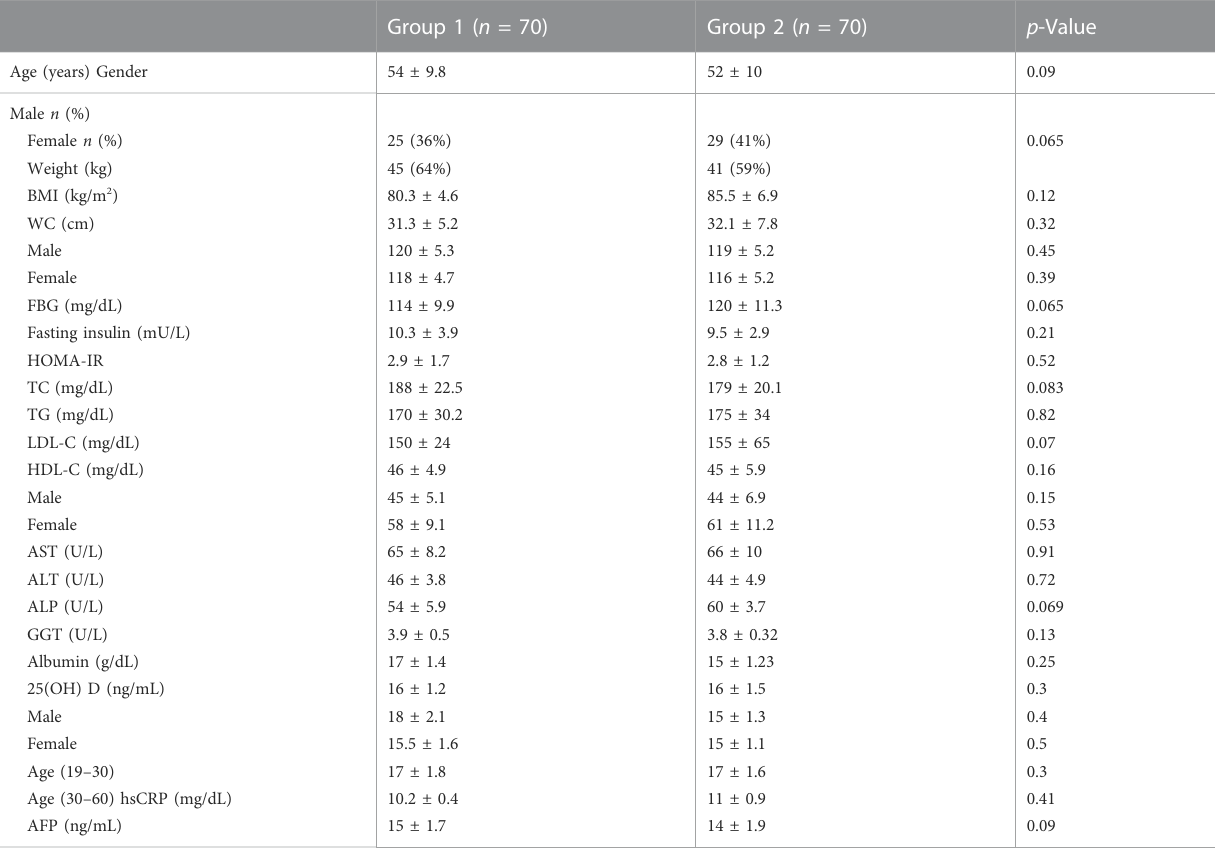
TABLE 1 Comparison of demographic data, anthropometric measures and laboratory measurements in the two studied groups at baseline. Group 1 ( n = 70) Group 2 ( n = 70)